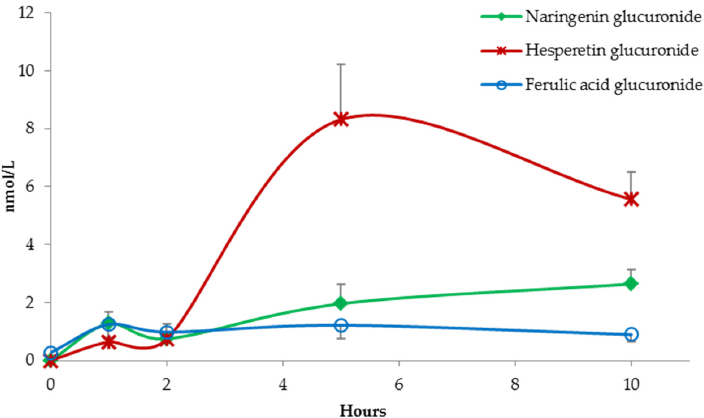
Figure 3. Absorption curves of naringenin glucuronide, hesperetin glucuronide, and ferulic acid glucuronide. Data are expressed as mean values and bars represent standard error of means (SEM).